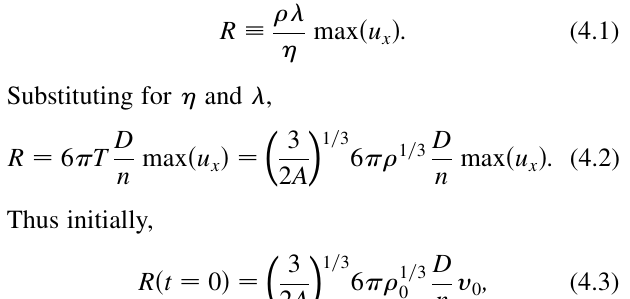
, as a function of time for turbulent flow (same run as Fig. 1). In (a) there is an initial i x